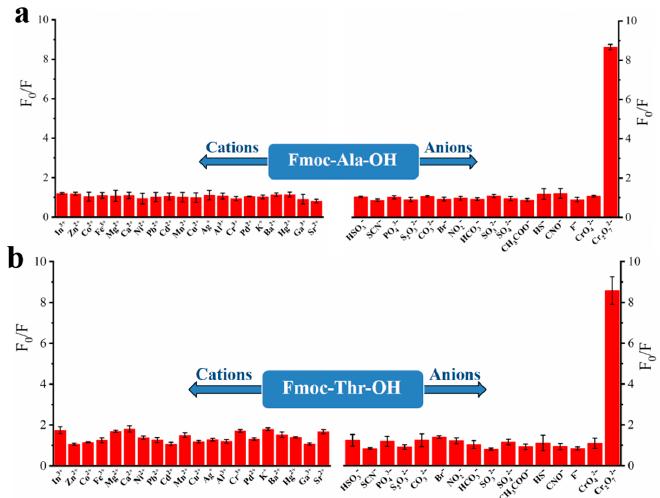
Figure 3. Fluorescence quenching of monomer Fmoc-Ala-OH ( a ) and Fmoc-Thr-OH ( b ) to various cations/anions.